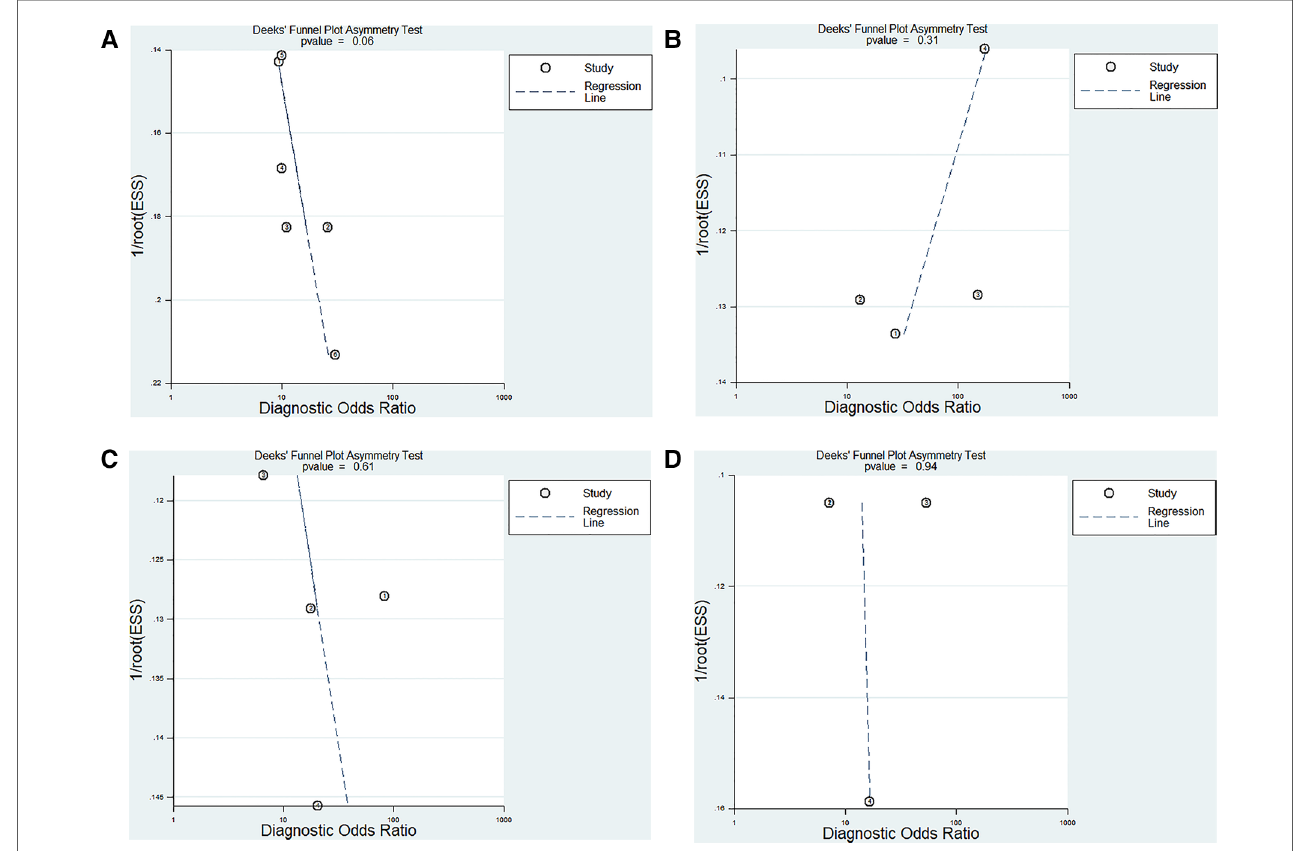
FIGURE 7 Deeks funnel plot evaluating the potential publication bias of the included studies. ( A ) ncRNAs diagnosis for KD-CAL; ( B ) ncRNAs combined with other laboratory indexes for KD; ( C ) ncRNAs differentiating acute KD patients from convalescent KD patients; ( D ) ncRNAs differentiating IVIG-resistant KD patients from IVIG-responsive KD